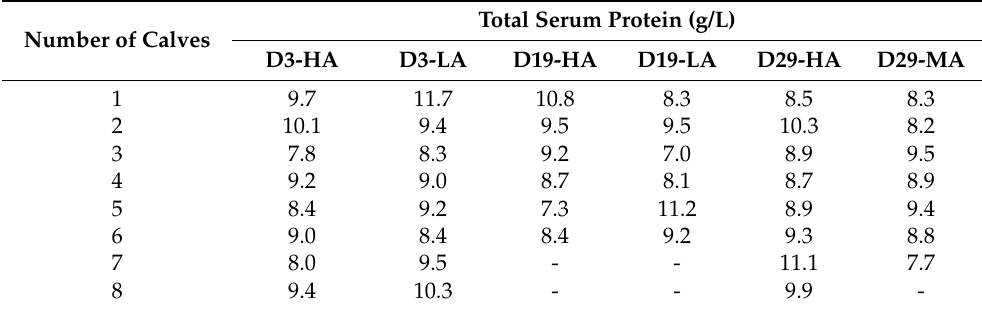
Table 1. Total serum protein of tested